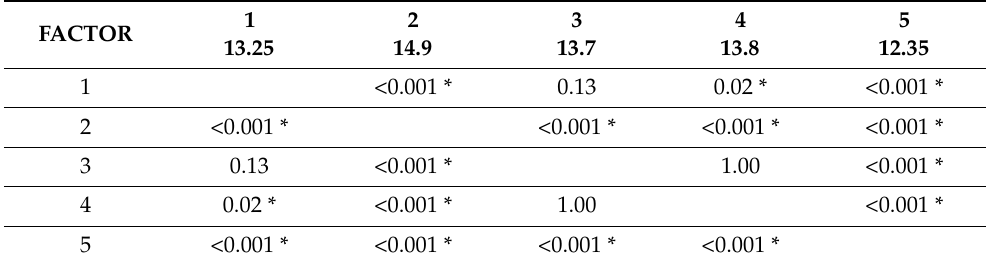
Figure 6. Distribution of the factors of the Resilience Measurement Scale depending on the group: Factor (1) perseverance and proactive approach, Factor (2) openness to new experiences, sense of humor, Factor (3) personal coping skills and tolerance to negative emotions, Factor (4) tolerance to failure, treating life as a challenge, Factor (5) optimistic attitude to life and the ability to organize oneself in difficult situations. Table 3. The level of statistical significance for the factor of the Resilience Measurement Scale (Bonferroni test).